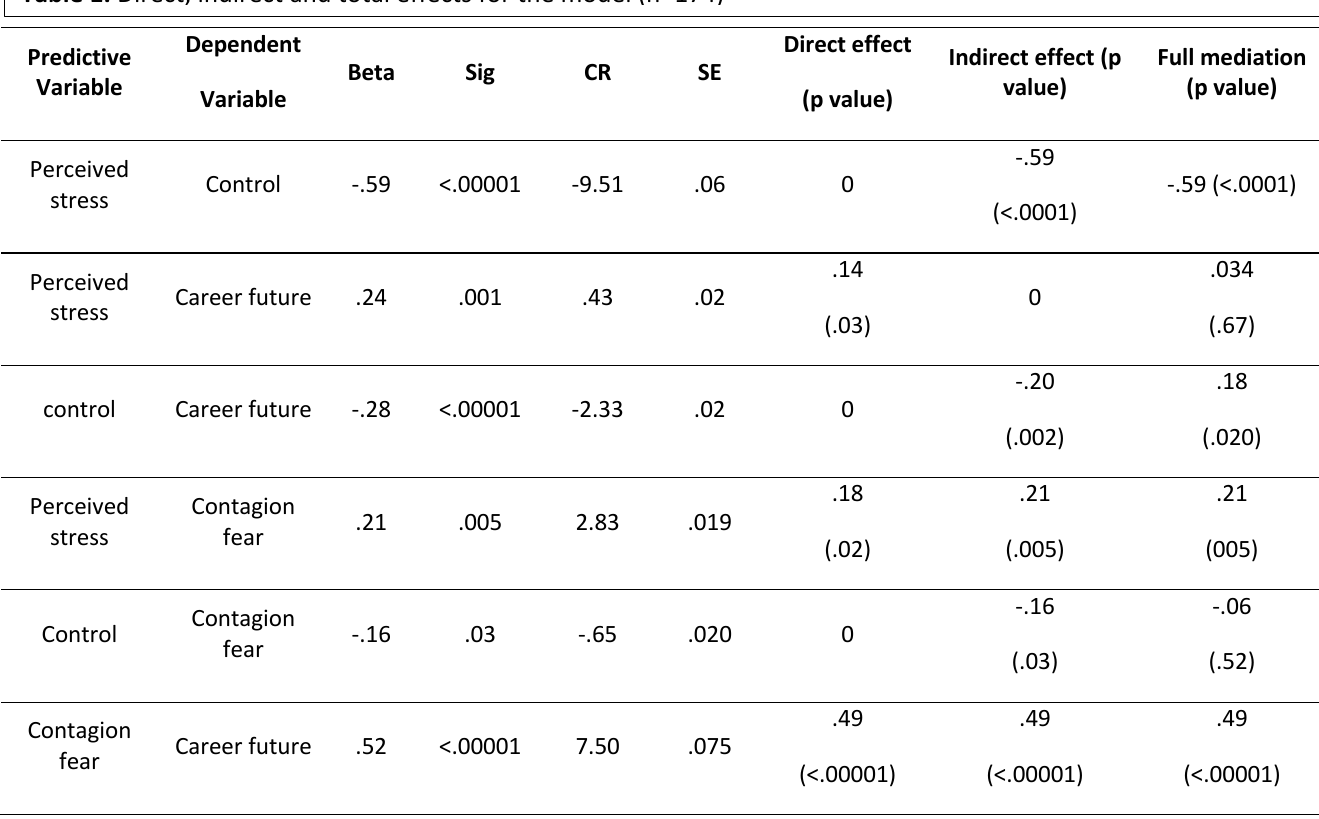
Table 1. Direct, indirect and total effects for the model